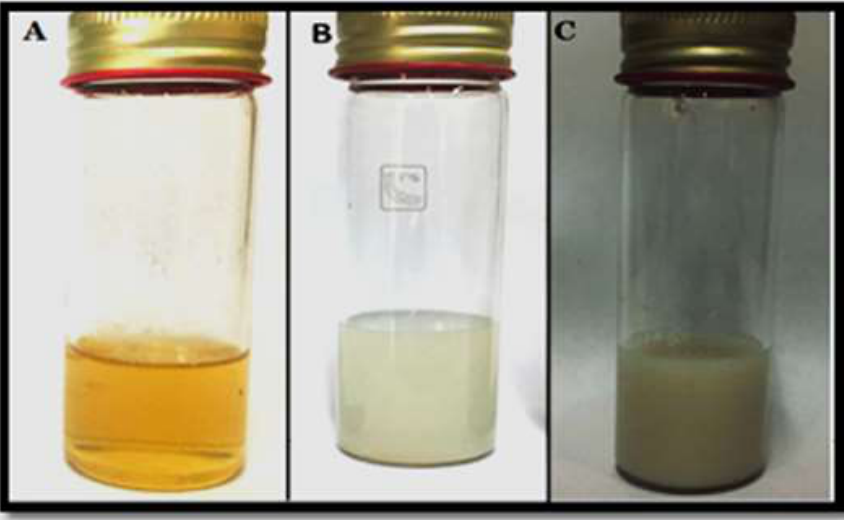
Figure 1. Synthesis of biosynthesized silver nanoparticles’, A (at zero time), B (when adding silver nitrate to the supernatant of S. pyogenes bacteria), and C (Silver nanoparticles’ after